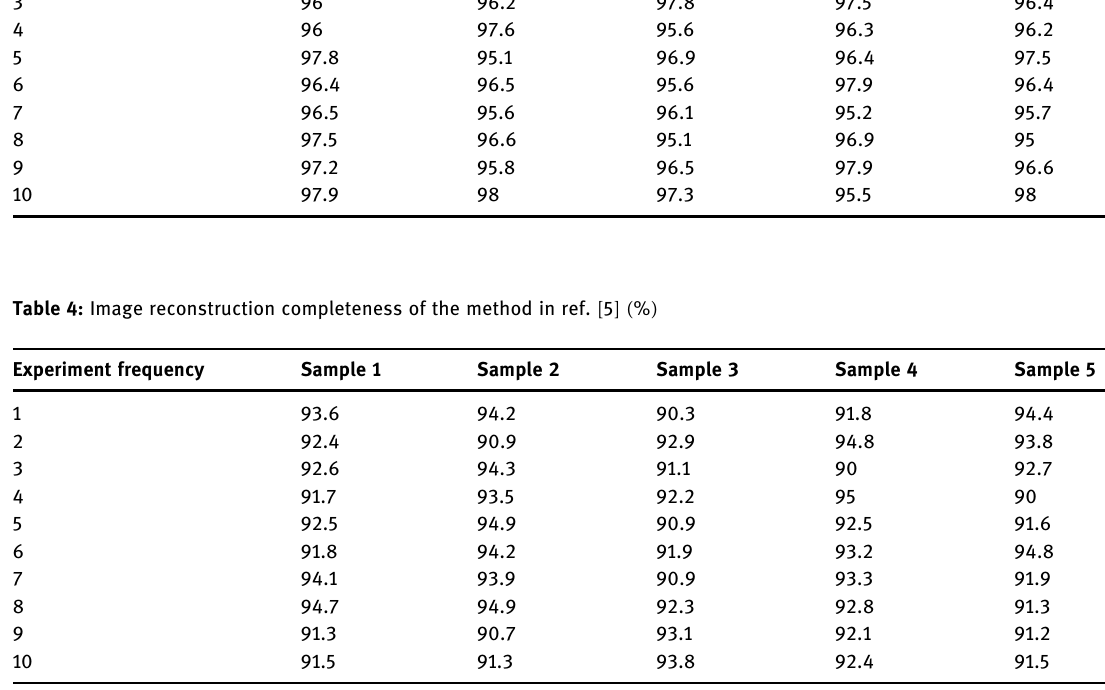
Table 5: Image reconstruction completeness of the method in ref. [ 6 ] ( % )